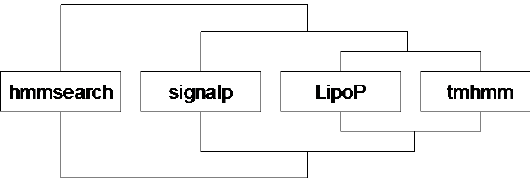
Figure 6: ProtocolDB graph for